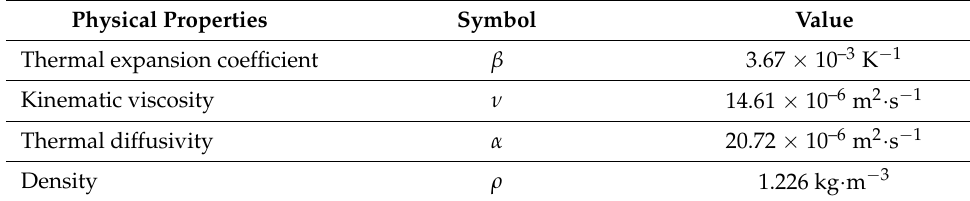
Table 2. Physical properties of air at T 0 = 15 ◦